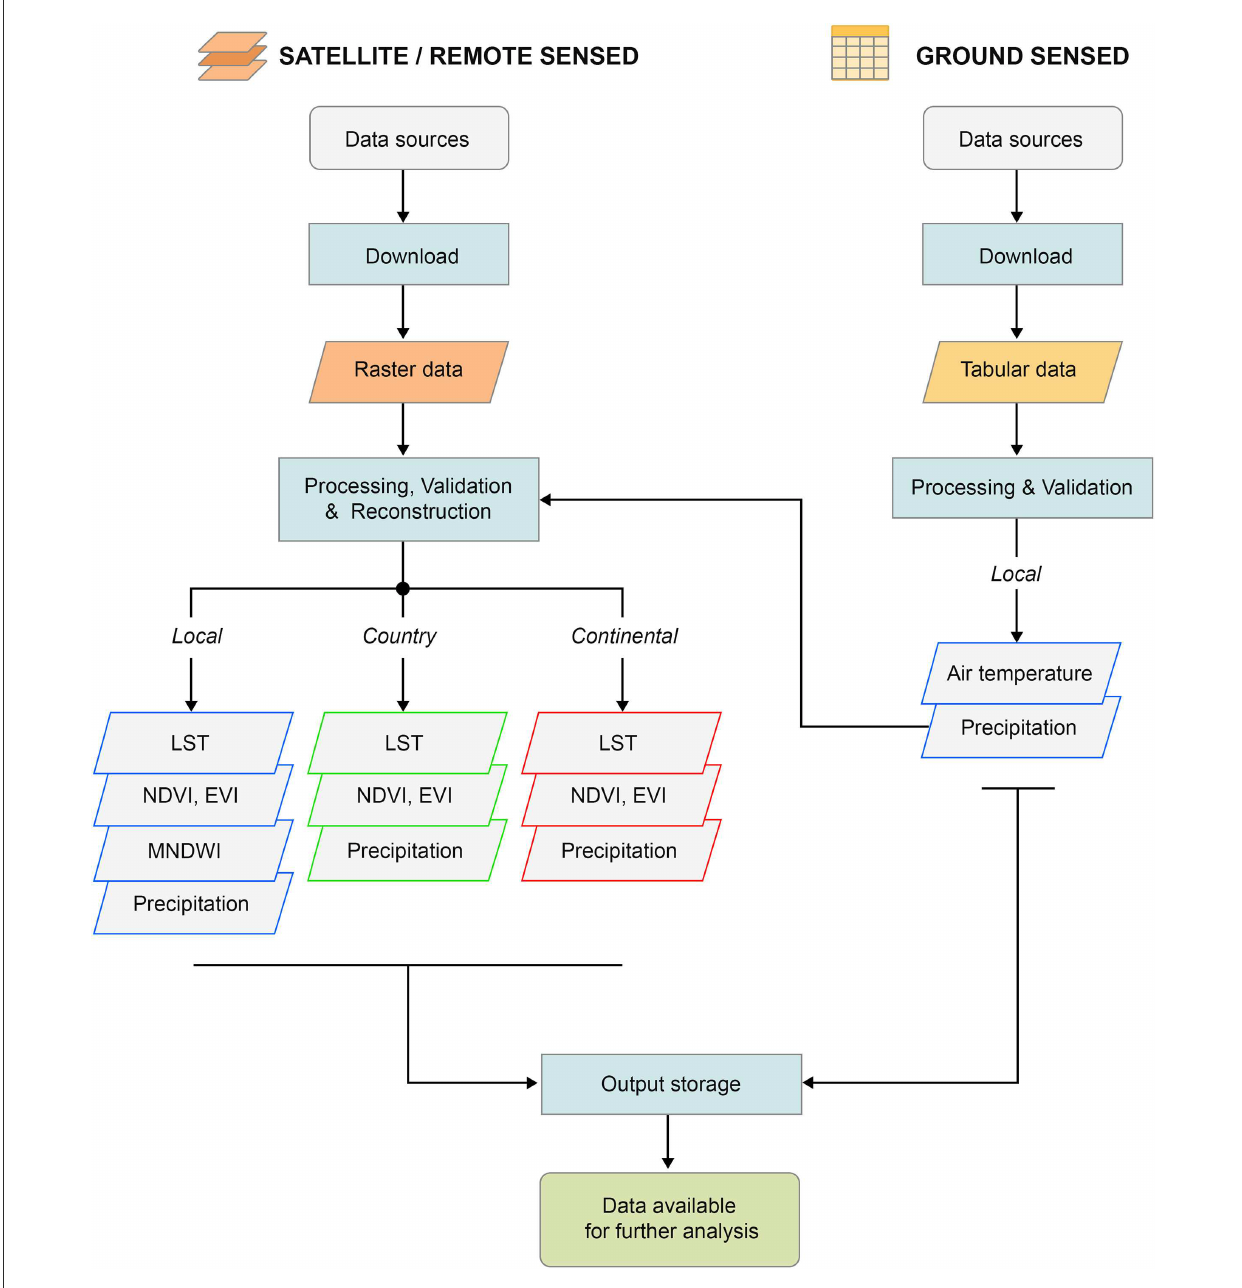
FIGURE2 General framework representing the flow at macro-level operated by the EVE system to produce the final dataset.